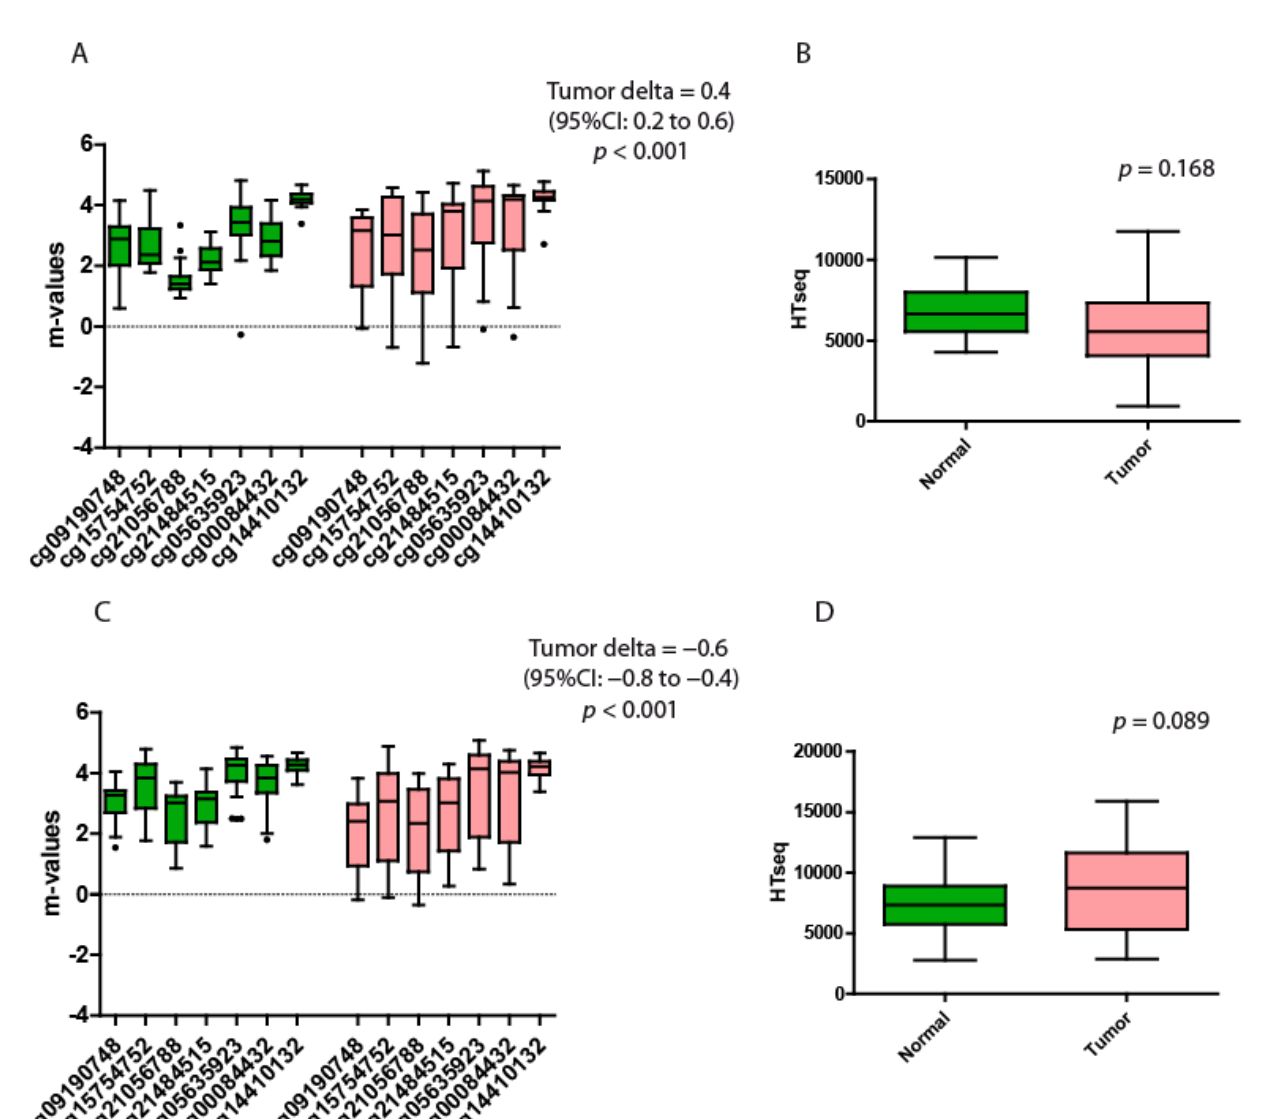
Figure 3. Quantitative methylation and gene expression analysis of the KIRP and KIRC datasets. ( A ) KIRP m-values of the 7 probes located at the open sea region of the locus SPG20. ( B ) KIRP expression levels of SPG20 in normal versus tumor tissues. The p -value indicates the statistical significance of the data. ( C ) KIRC m-values of the 7 probes located at the open sea region of the locus SPG20. ( D ) KIRC expression levels of SPG20 in normal versus tumor tissues. The p -value indicates the signifi- cance of the data. Green boxplots represent the nontumoral tissues (solid tissue normal datasets), while red boxplots represent the tumor tissues. The black dots represent the outliers. Each probe is identified with a specific alphanumeric code. The tumor delta is a value that represents the variation between the two groups. The higher the value of the tumor delta, the greater the variation between the two groups. Each box plot displays the median value and the whiskers the interval between the 1st and 3rd quartiles.